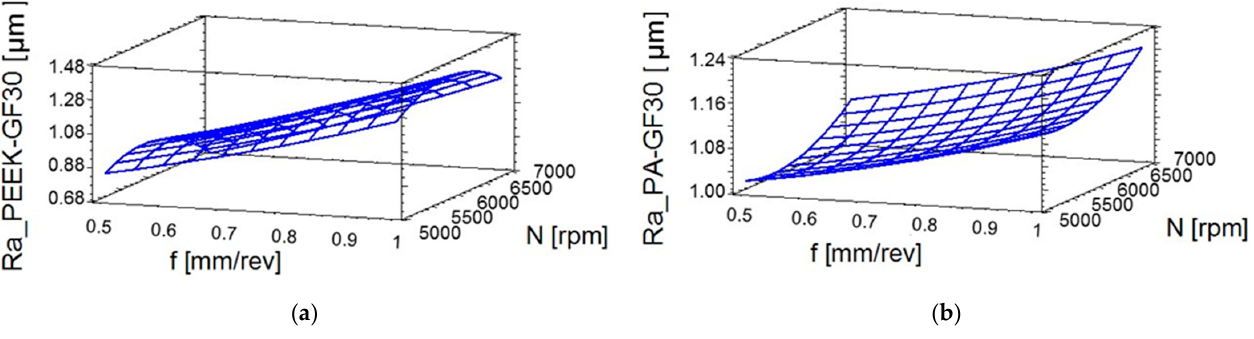
Figure 5. Estimated response surface for roughness: ( a ) for Ra_PEEK-GF30 and ( b ) for Ra_PA66-GF30. The optimal value for roughness in PEEK-GF30, 0.6881 µ m, was obtained for N = 7000 rpm and f = 0.5 mm/rev. With respect to PA66-GF30, the optimal roughness was 1.0134 µ m for the same feed rate and 5522